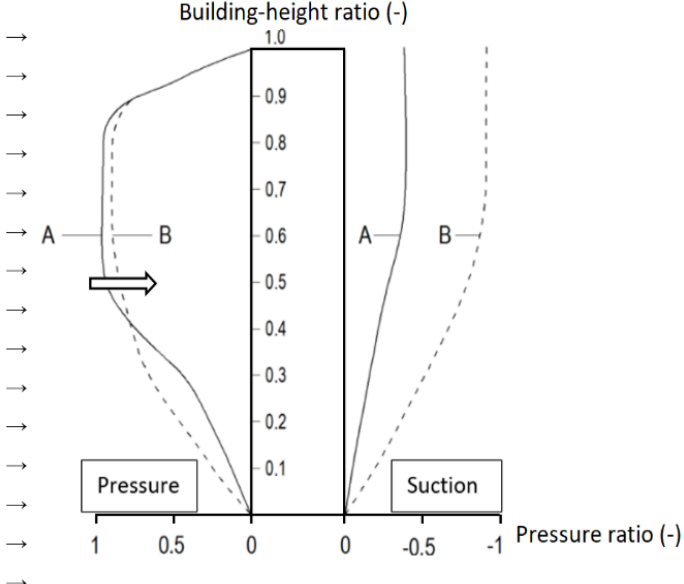
Figure 1. The approximate influence of the facade air permeability on the pressure and suction distribution on windward and leeward side for tall building with rectangular ground plan, A—zero air permeability building, B—air permeability building, (source authors, processed according to [11]).